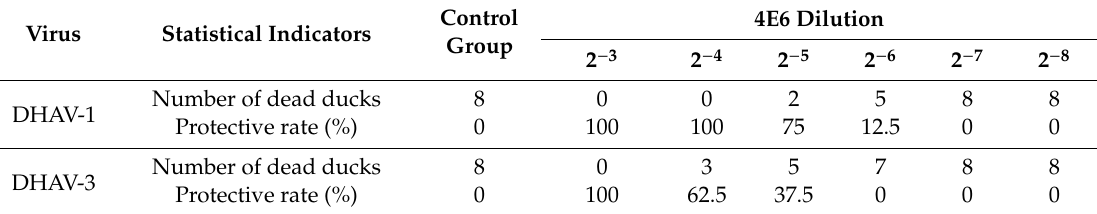
Table 2. Neutralization assay of monoclonal antibody (mAb) 4E6 against Duck hepatitis A virus (DHAV)-1 and DHAV-3.